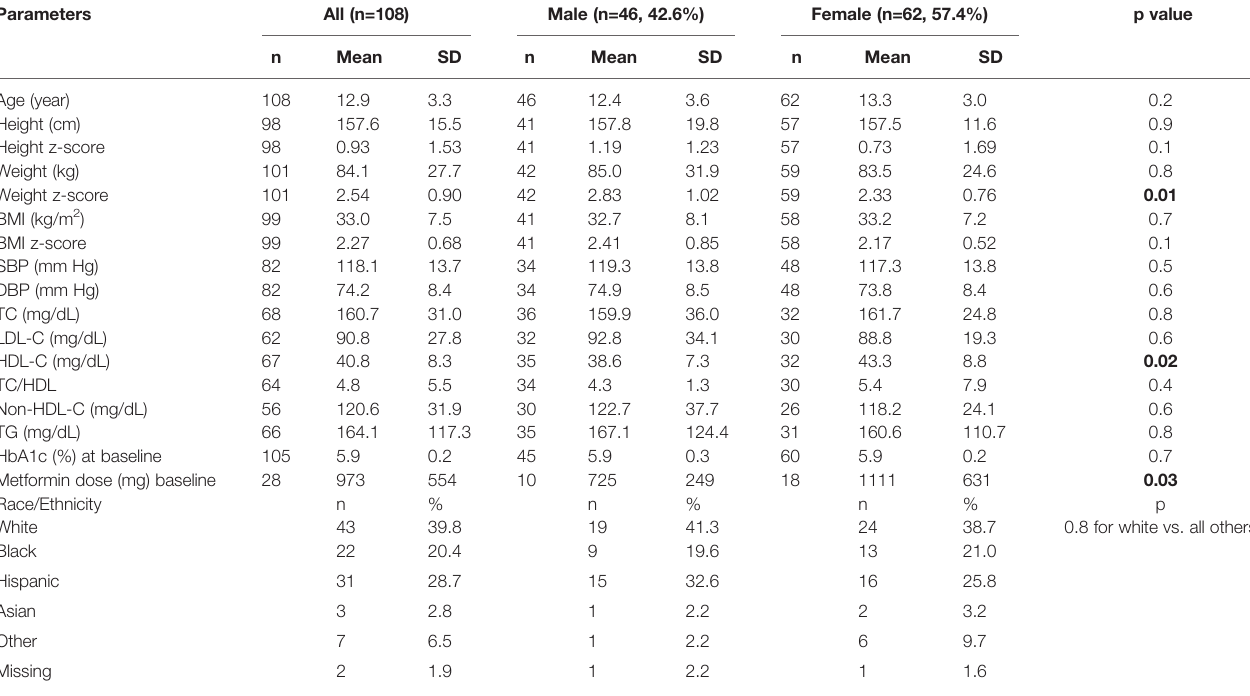
TABLE 1 | Anthropometric and biochemical characteristics of the subjects strati fi ed by sex.